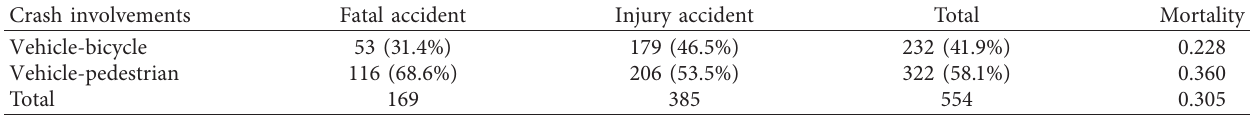
Table 7: Statistical information of crash involvements for injury severity.